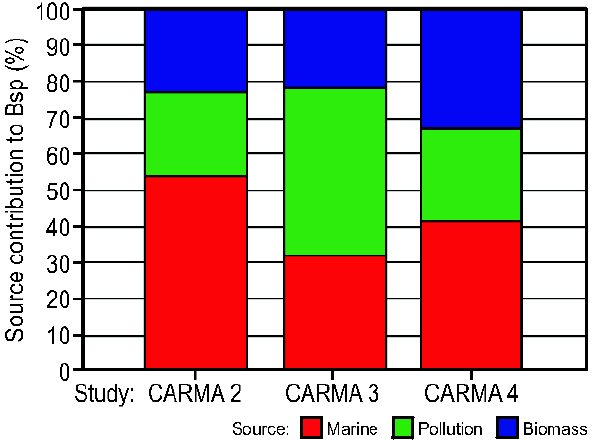
Fig. 13. Study average source contributions by each of three source categories (see text) to the aerosol light-scattering coefficient (Bsp). Uncertainties associated with the mean source estimates are given in Table